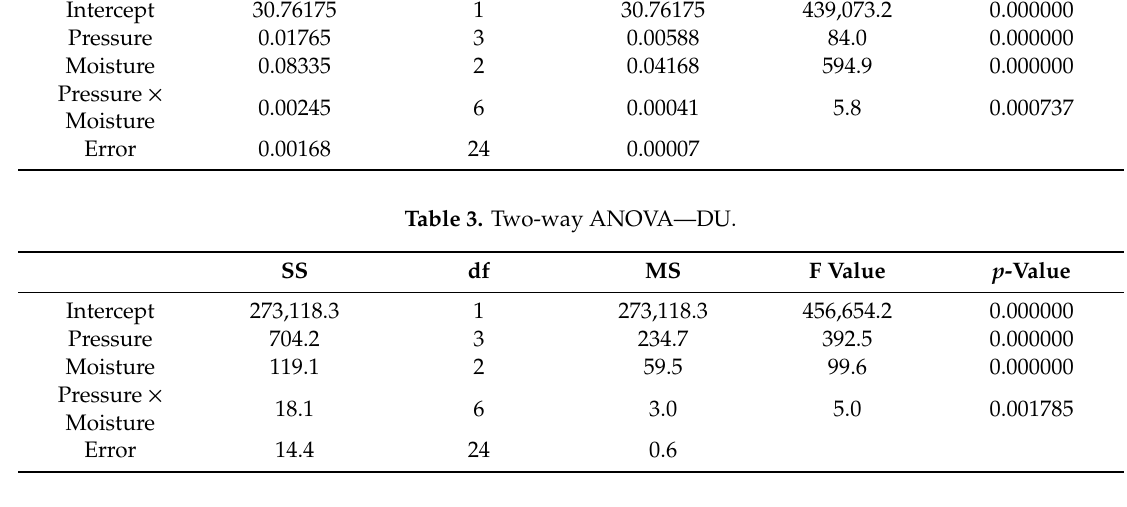
Table 2. Two-way analysis of variance (ANOVA) — DE.